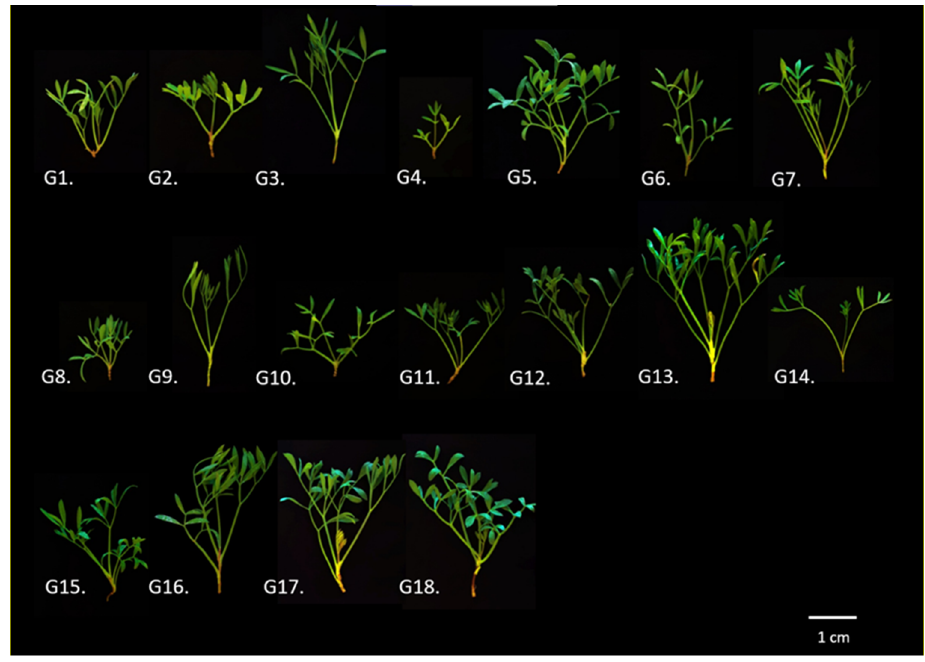
Figure 6. Indicative visual phenotype of the 18 native Greek rock samphire genotypes studied. Explanations for the abbreviations G1–G18 are given in Table 1.